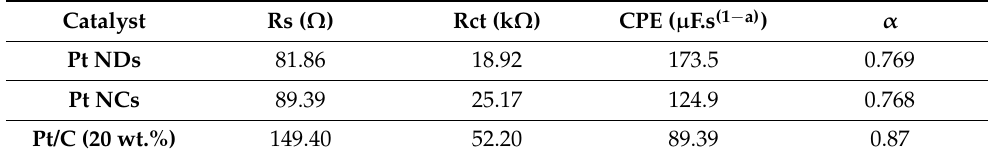
Table 2. Analysis of EIS measured in 0.1 M KOH.